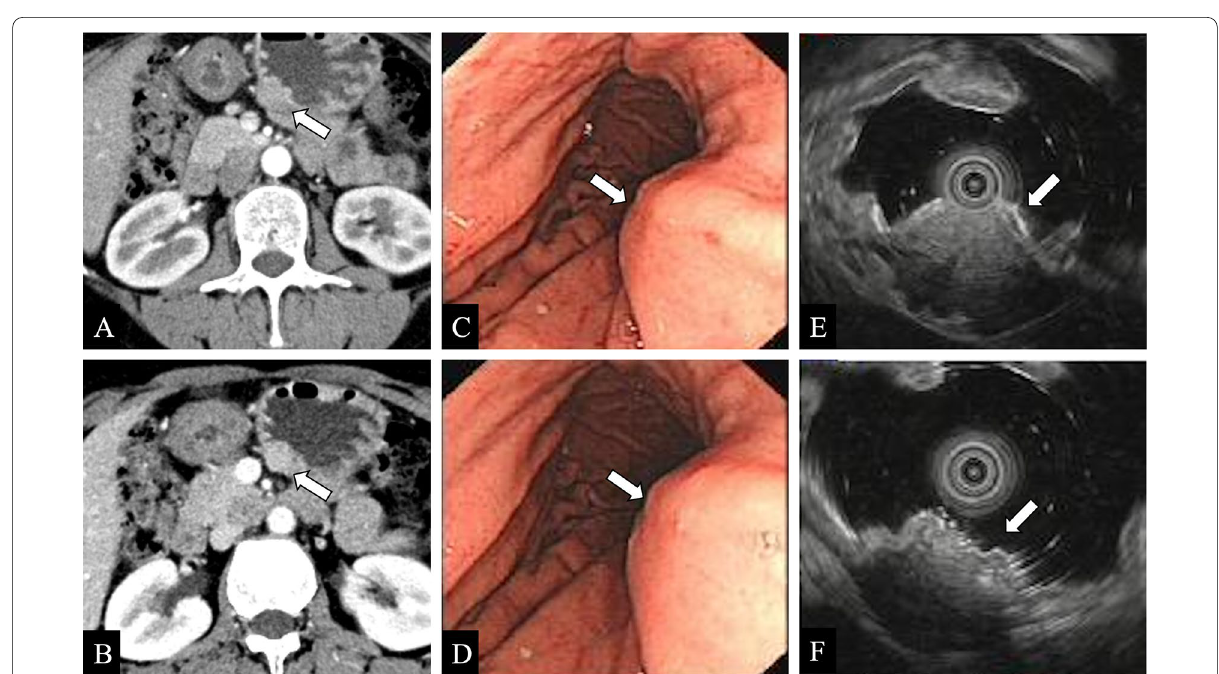
Fig. 5 Images demonstrating the gastric body with a submucosa heterotopic pancreas (white arrows) identified within the wall of the stomach. a, b Contrast‑enhanced axial CT images in arterial and venous phases. c, d Upper endoscopy images. e, f Endoscopic ultrasonography